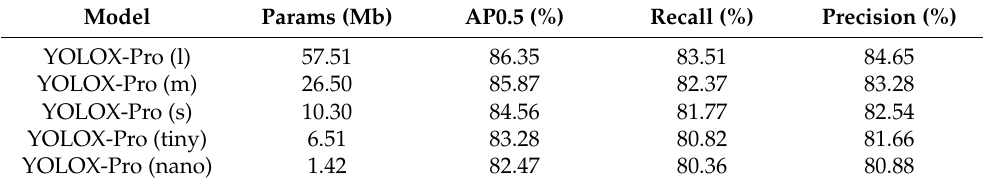
Table 8. Results of the YOLOX-Pro network for detecting the UAV dataset.